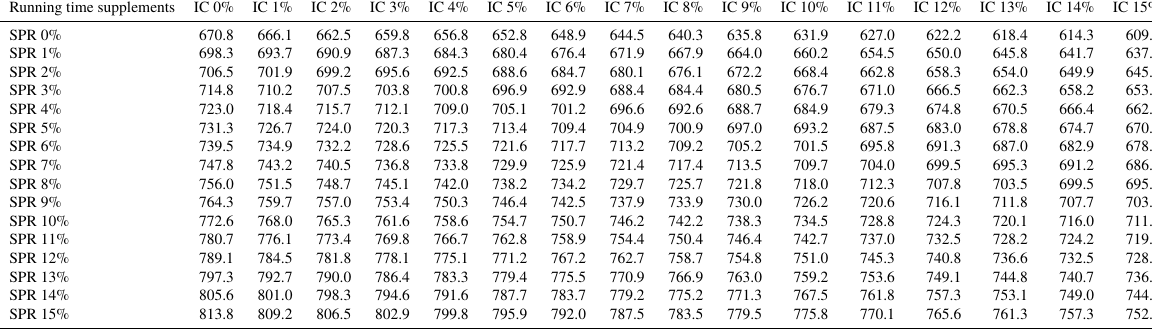
Table 12: Extended cycle time (s) per IC-SPR cycle for different running time supplements for the real-world case study